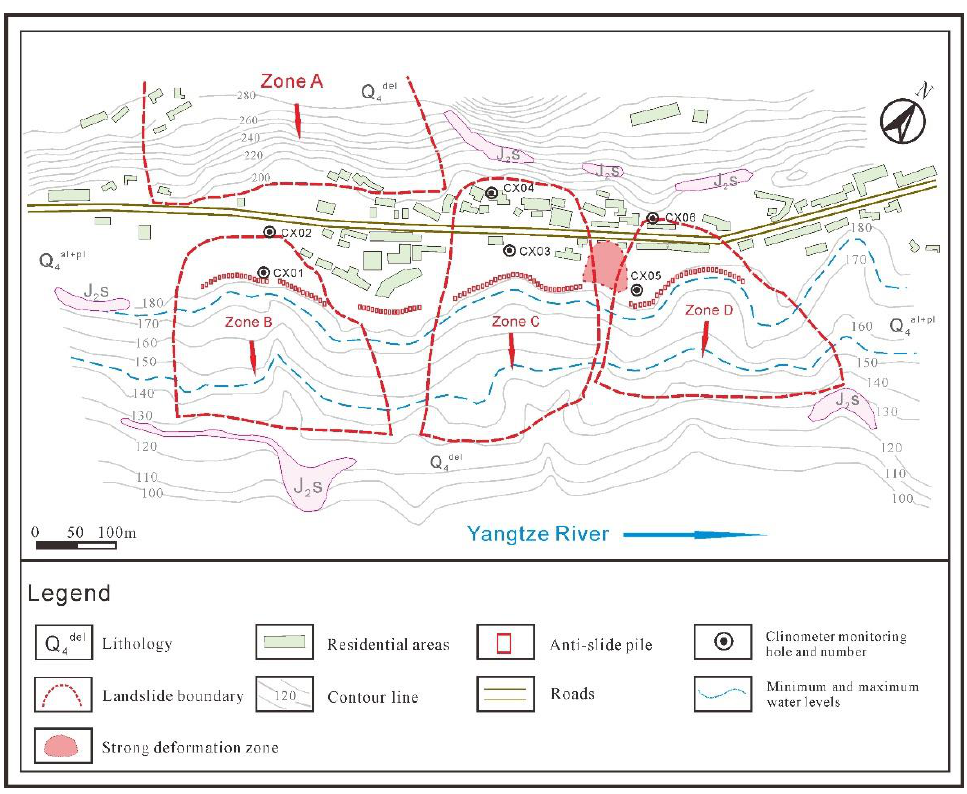
Figure 10. The layout map of the Dazhou landslide showing the distribution of the anti-slide piles.